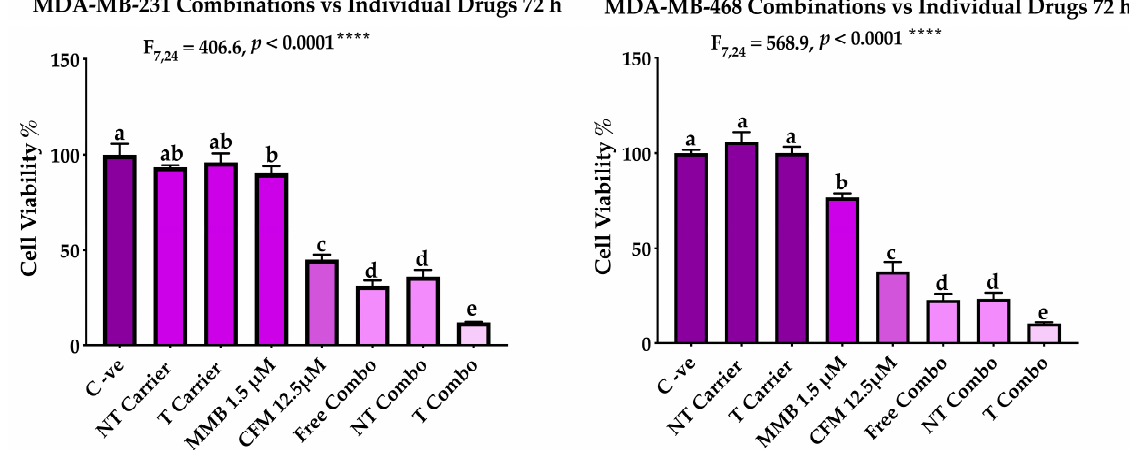
Figure 6. The performance of MMB + CFM-4.16 combinations (free combo, NT combo, and T combo) vs. the individual free drugs. Note: T combo (CD44-T-PNPs + MMB) and NT combo (NT-PNPs + MMB).